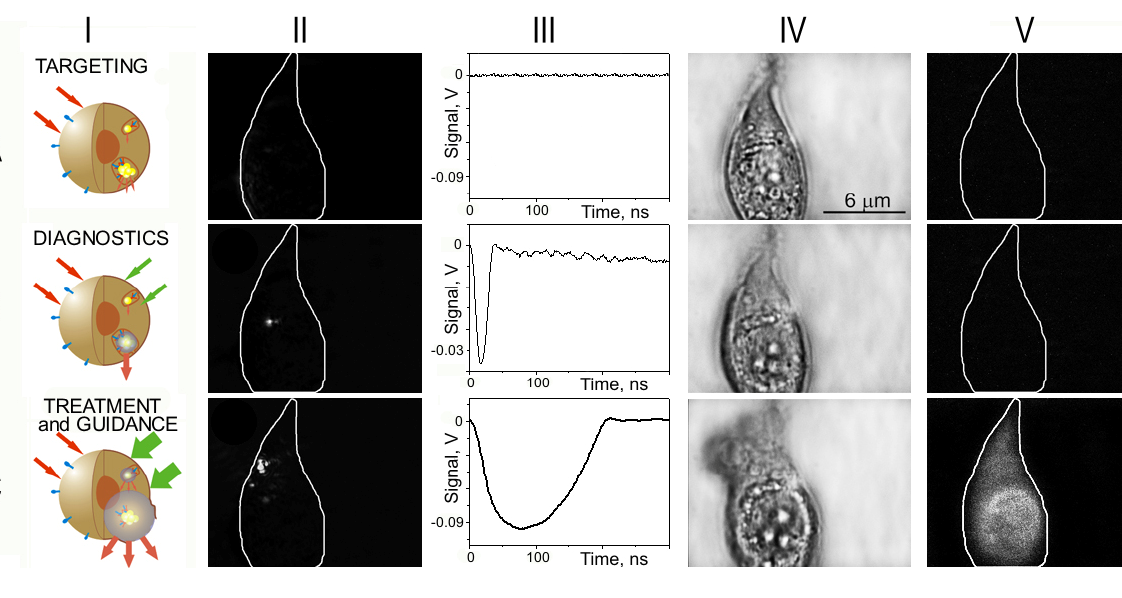
Figure 17. Targeting the cell with gold NPs ( a ) and the optical generation and detection of intracellular PNBs: the 1st PNB non-invasively amplifies optical scattering ( b ), while increasing the fluence of the pump laser pulse induces the 2nd PNB that mechanically damages the cell ( c ); I—stages of PNB theranostic action; II—optical pulsed scattering images of one cell with the membrane border shown with a white line; III—optical time response of the PNB shows its lifetime; IV—bright light and V—fluorescent (ethidium bromide-specific) images of the cell show it before (a) and after the generation of the 1st (b) and the 2nd (c) PNBs